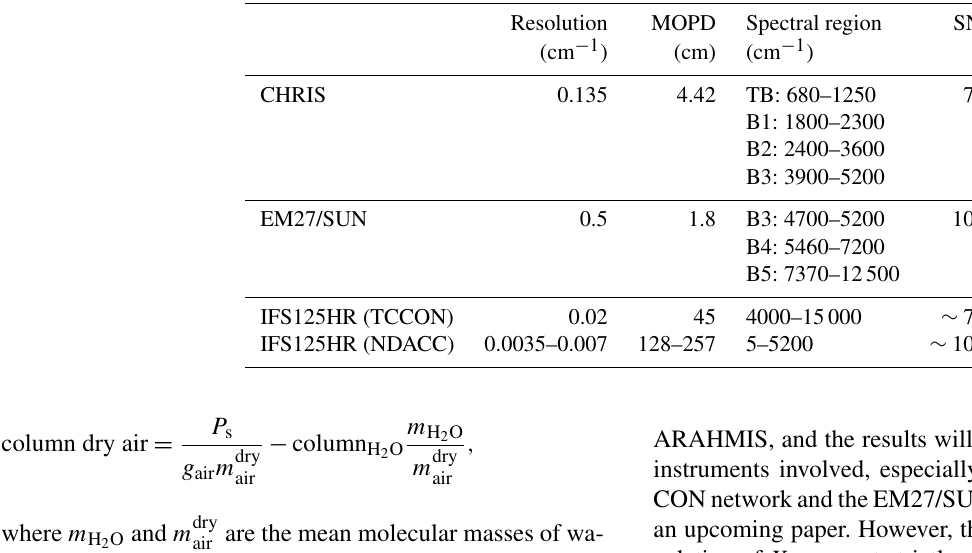
Figure 9. Same as Fig. 8 but for CH 4 with bands TB, B2 and B3 and all the bands together. Table 3. Instrumental characteristics of CHRIS, the EM27/SUN and the IFS125HR of both NDACC and